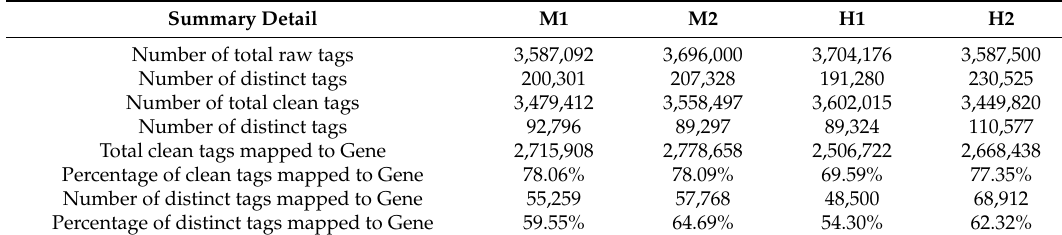
Table 1. Statistical results of digital gene expression profiles. M1 and M2: control ponkan leaves sampled at 13 and 26 weeks post inoculation (wpi), respectively; H1 and H2: Citrus HLB (Huanglongbing) infected ponkan leaves sampled at 13 and 26 wpi, respectively.